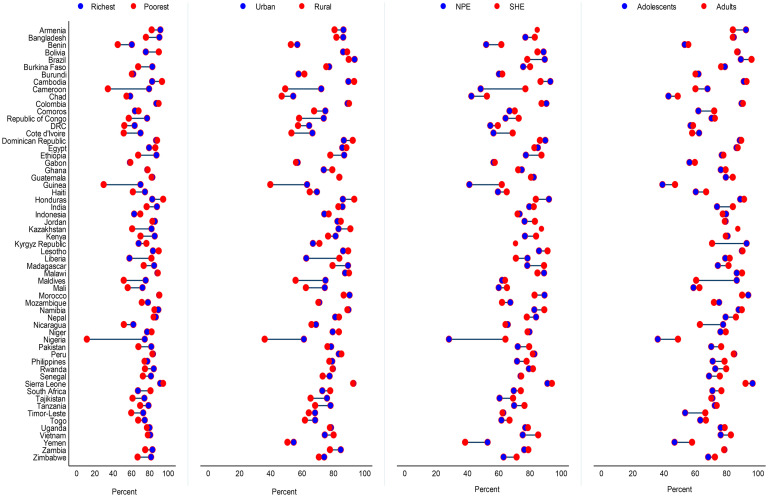
Projected Gaps in Composite Coverage Index Across Countries by Wealth Quintiles, Place of Residence, and Women’s/Mother’s Education and Age in 2030Abbreviations: NPE, no education and primary-level education; SHE, secondary or higher-level education.